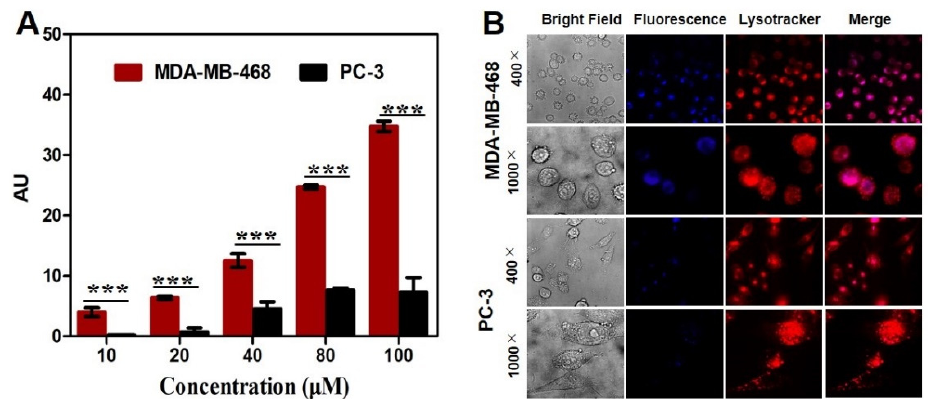
Figure 4. ( A ) Quantitative analysis of fluorescence. Error bar represents standard deviation ( n = 3). *** denotes p < 0.001. ( B ) Colocalization studies of MDA-MB-468 and PC-3 cells following incubation with nonradioactive probe [ 19 F] SF-AAN (50 µ M) for 6 h and the lysotracker red (1 µ M) for another 10 min. Scale bar: 20 μ m.